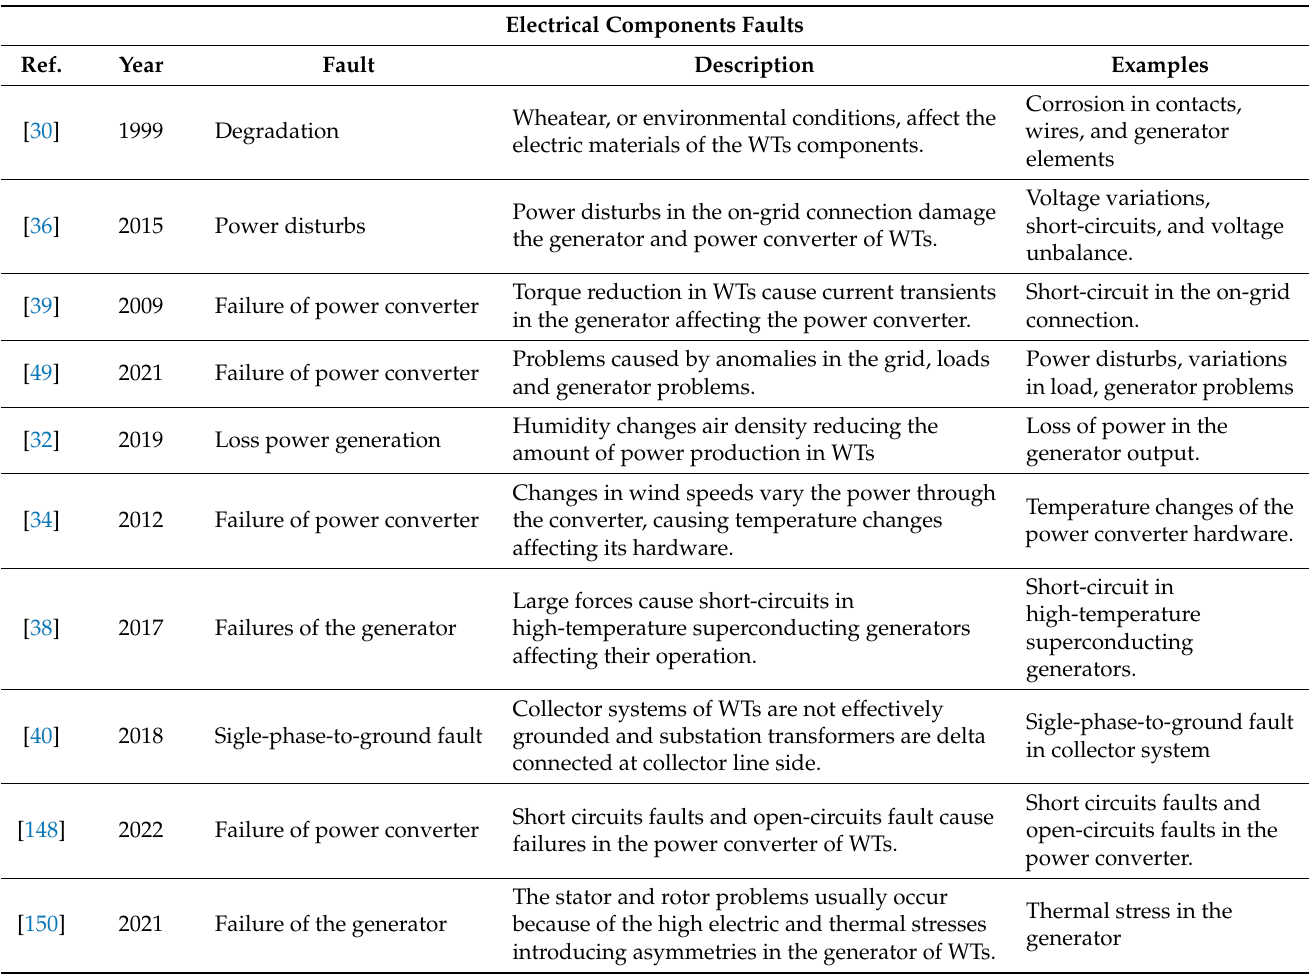
Table 3. Summary of the common faults of WTS reported in the literature. Considering electrical and mechanical components